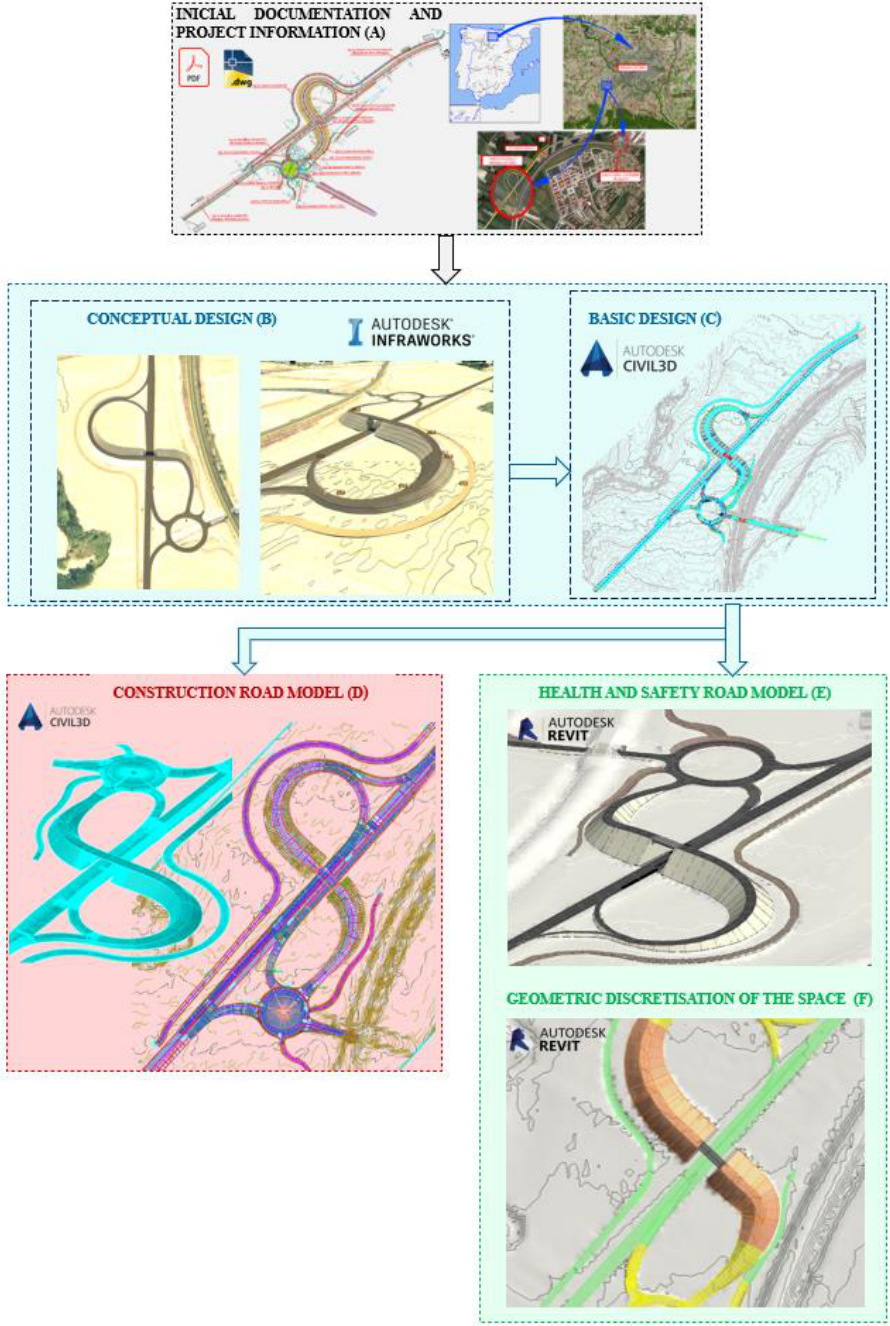
Figure 1. Conceptual diagram of the workflow used to create the health and safety road model (( A ) Background information on the project, ( B ) Conceptual design of the project in InfraWorks 2020, ( C ) Design model with a low level of detail associated with a basic project, ( D ) Design model with a high level of detail associated with a construction project in Civil 3D 2020, ( E ) Low level of detail design model associated with a basic project in Revit 2020, ( F ) Model with information on the result of the implemented risk